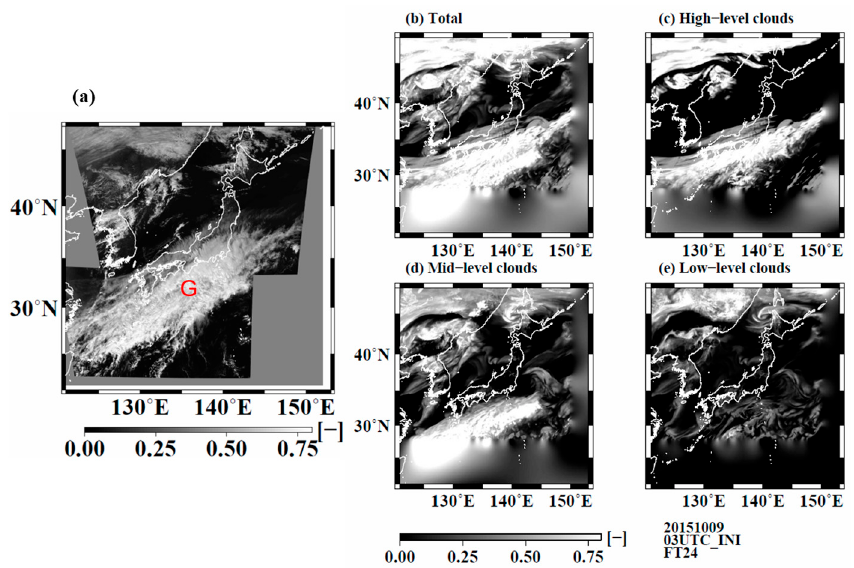
Figure 15. Same as Figure 14, but for on 10 October 2015.